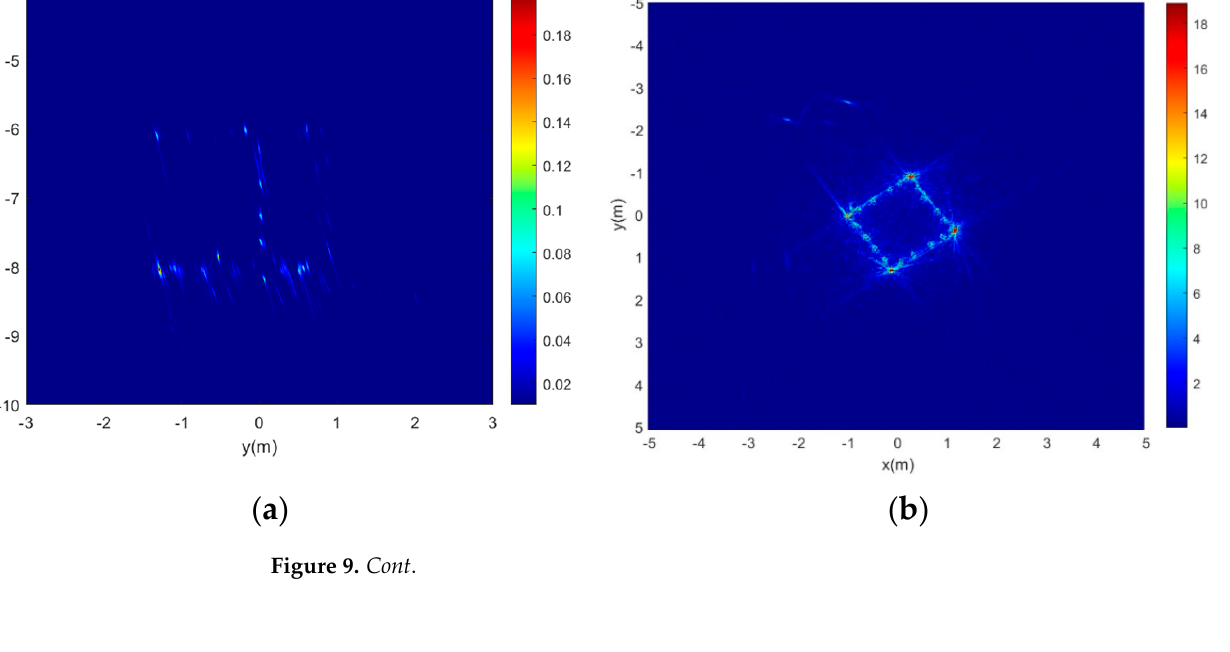
( c ) Figure 9. The 3D imaging experimental results of CSAS for steel cube target. ( a ) The reconstruction in the height direction at angle bin = 200; ( b ) the 2D slice imaging result at steel cube bottom; and ( c ) the 3D imaging result of the steel cube. It also contains the bottom image of lake. 5. Conclusions Three-dimensional imaging is beneficial for verification and identification of under- water targets [43–45]. For the application of accurate 3D imaging for underwater targets, a novel 3D imaging process was proposed in this study. Due to the short wavelength of transmit waves, the sparse recovery method, which is based on sparse Bayesian learning, was applied to reconstruct scattering coefficients in the height direction with complex 2D images obtained by CSASA in each angle. After accomplishing the reconstructions of all angle bins, then, the high-resolution 2D imaging in horizontal slice was implemented by the Fourier slice theorem and the final 3D imaging was obtained by coherence stacking in the height direction. A numerical simulation was performed to verify the high-resolution imaging ability of the proposed imaging model and algorithm. Furthermore, the experi- ment had been conducted to verify the algorithm by a USV-mounted CASAS system in a lake. The experiment results verify the high-resolution imaging ability of the proposed imaging model and algorithm, which indicates that the USV-mounted CASAS system is suitable for 3D imaging of underwater targets. Author Contributions: Conceptualization, S.Z.; methodology, S.Z. and W.F.; software, S.Z.; valida- tion, S.Z., W.F. and X.D.; formal analysis, S.Z.; investigation, W.F.; resources, S.Z.; data curation, S.Z. and W.F.; writing—original draft preparation, S.Z.; writing—review and editing, S.Z.; visuali- zation, X.D.; supervision, W.F.; project administration, W.F.; funding acquisition, W.F. All authors have read and agreed to the published version of the manuscript.